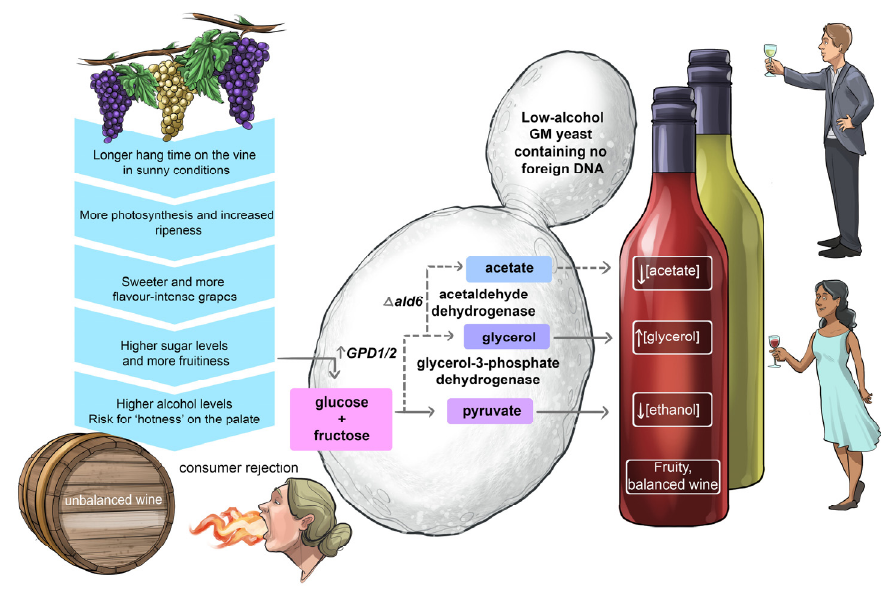
Figure 16. The construction of low ‐ alcohol wine strains of Saccharomyces cerevisiae (adapted from